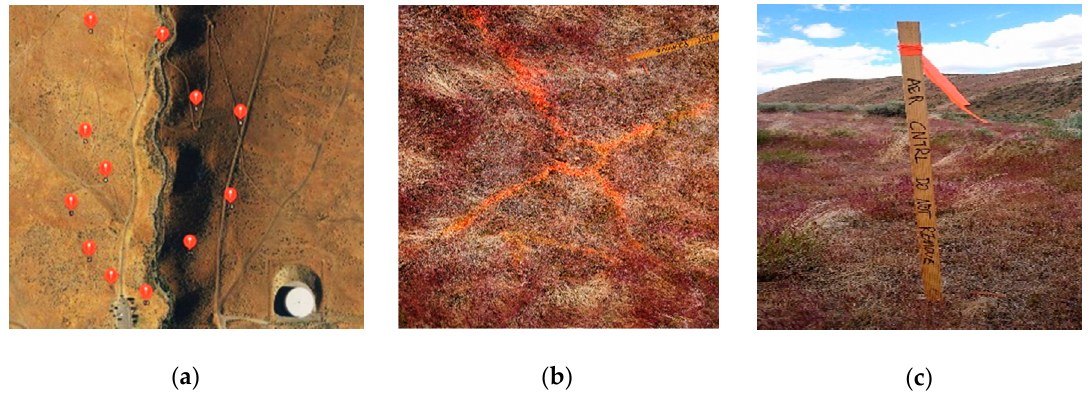
Figure 7. ( a ) Ground control points (GCPs) at Keystone Trailhead; ( b ) X-mark GCP; ( c ) Survey stake.